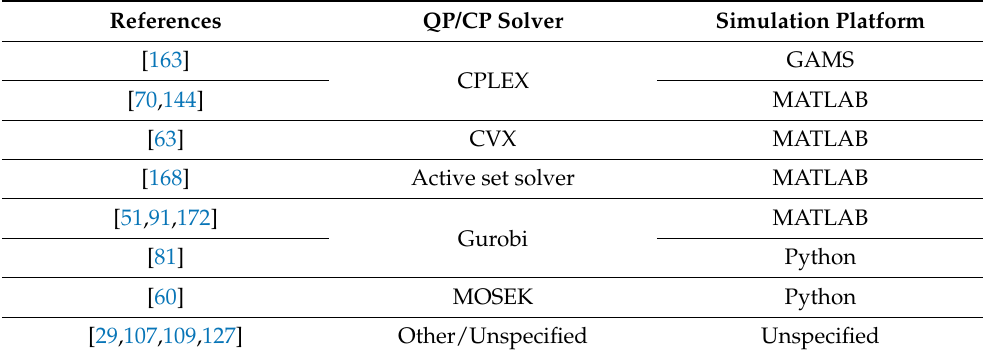
Table 7. Solvers and simulation platforms employed in quadratic or convex